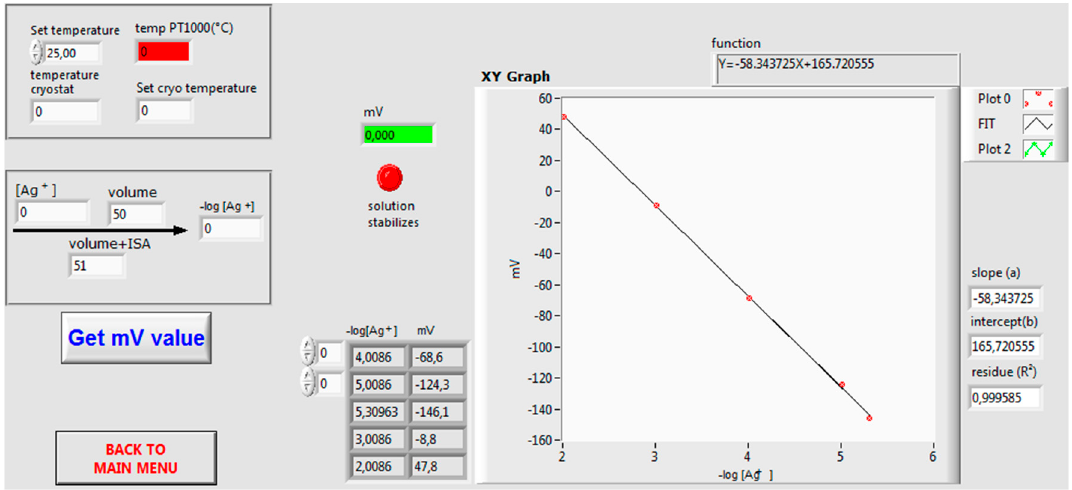
Figure 4. Linear regression line, E versus –log c(Ag + ) for the standardization of a silver nitrate